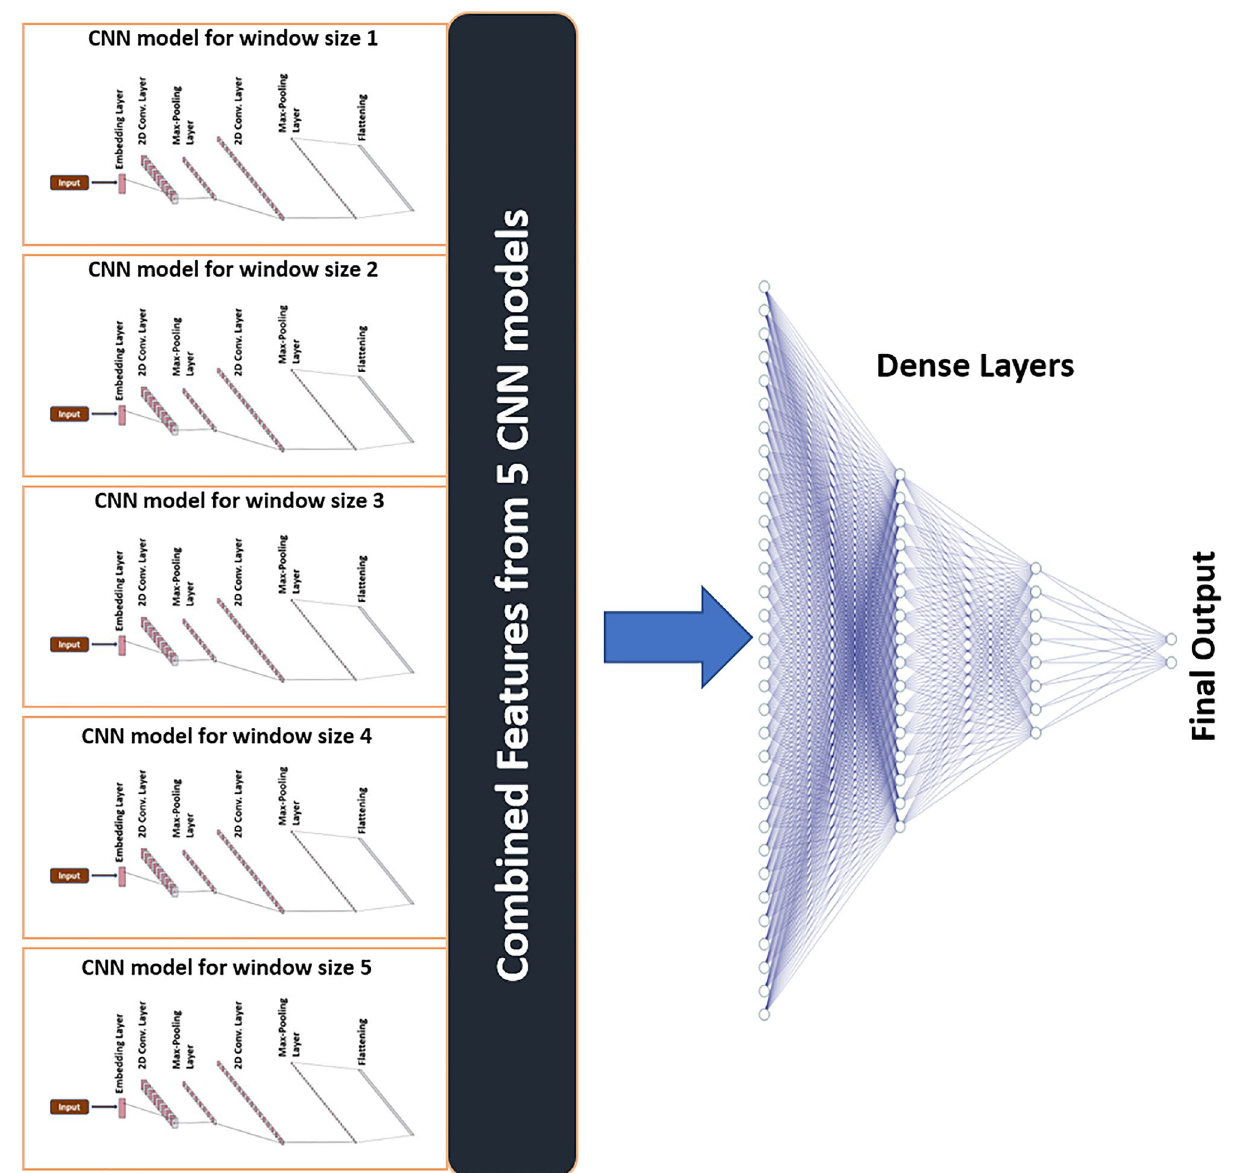
Figure 1. Multi-windows model Chlamy-MwPhosSite combining features from five models with different window